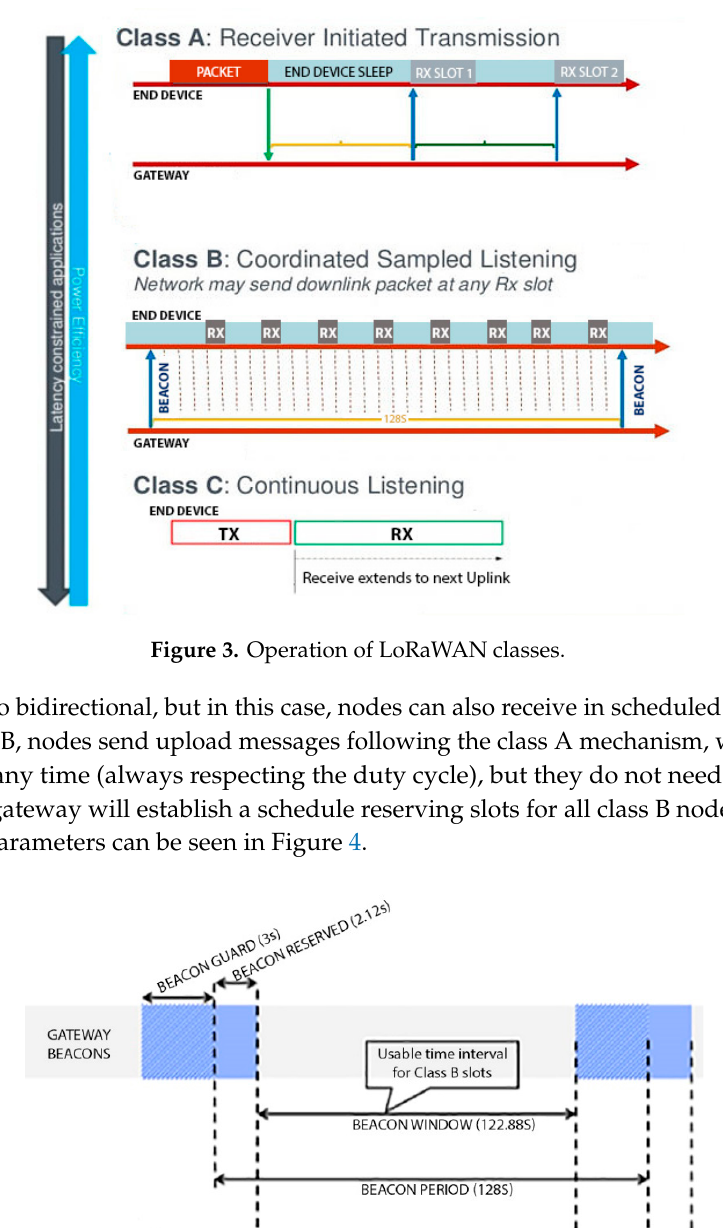
Figure 2. LoRaWAN architecture.